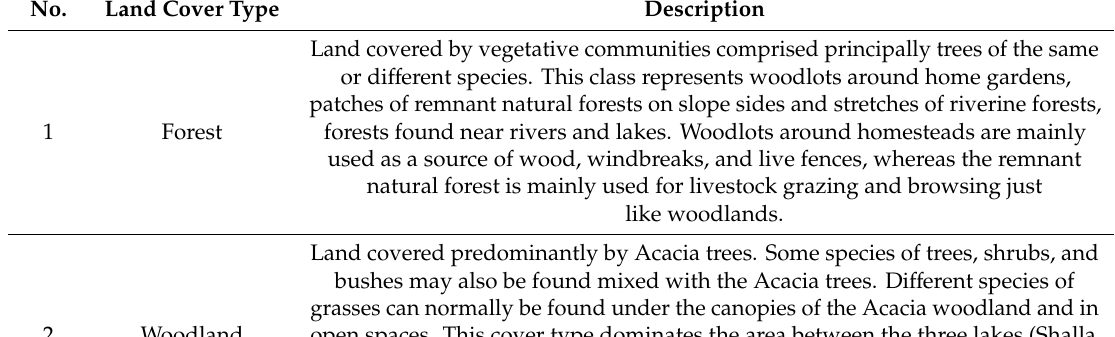
Table 2. Description of land cover types identified in the CRV of